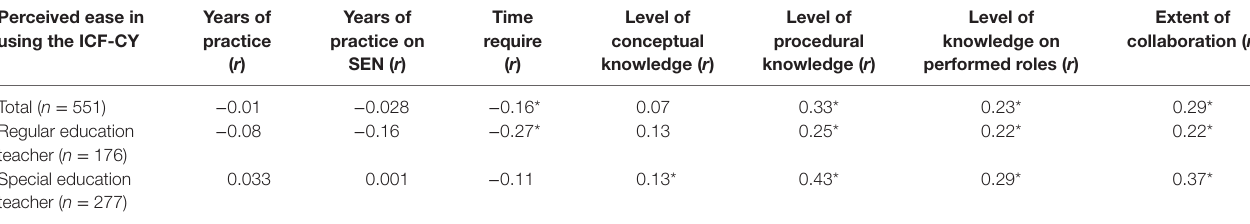
Table 5 | Pearson’s correlation coefficient ( r ) between the perceived ease in using the ICF-CY and other dependent variables. Perceived ease in using the